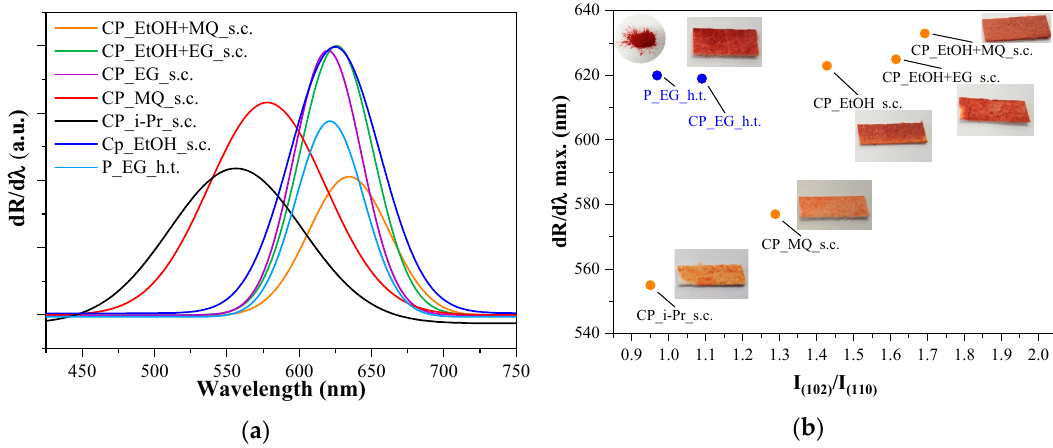
Figure 2. Measured optical properties and photos of immobilized BiOI catalysts ( a ): first derivative of di ff use reflectance spectra ( b ): correlation between the dR / d λ maximum and the ratio of the two main crystallographic planes.